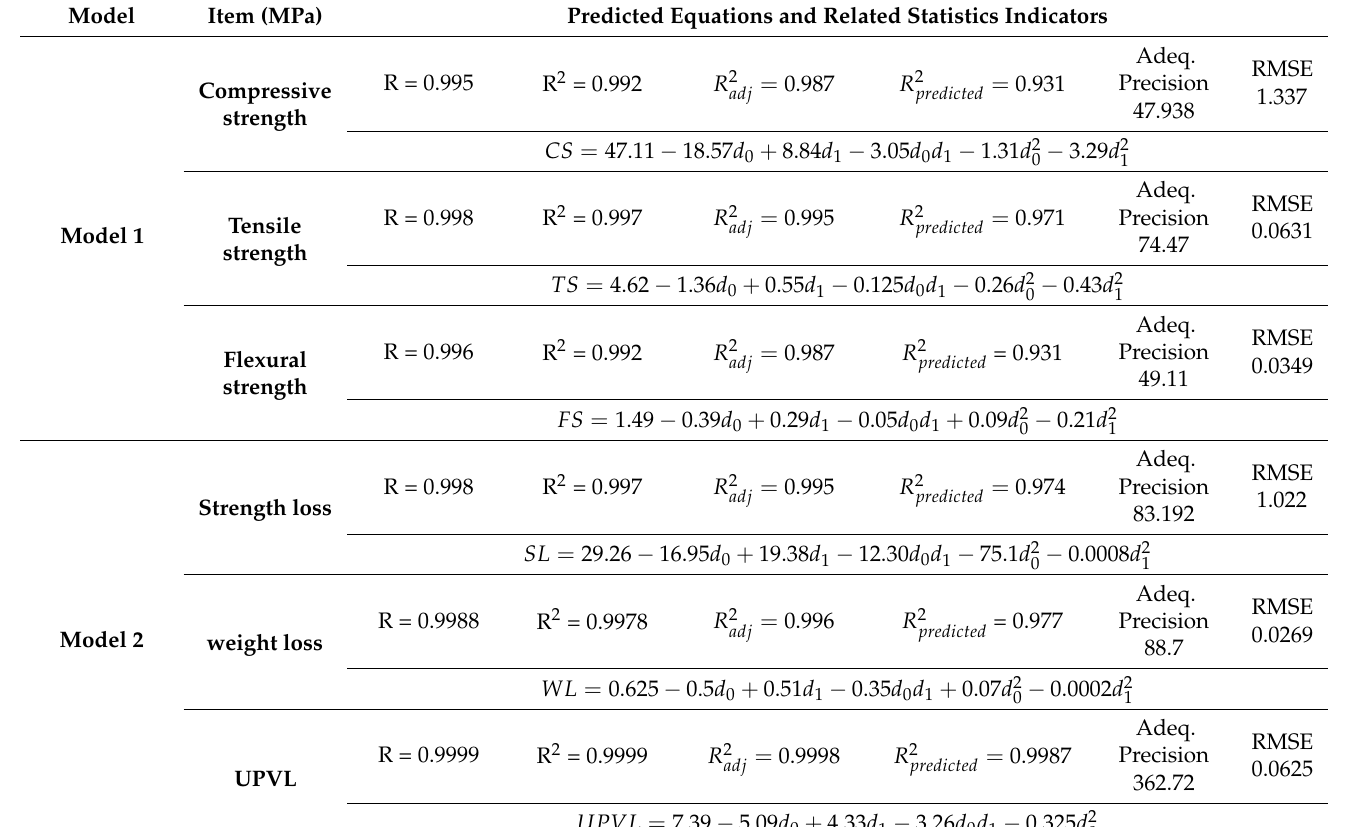
Table 2. Predictive equations of SCAAC